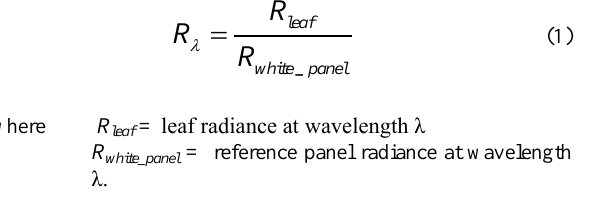
Figure. 1 is the optical diagram of HSL system. The laser emission component of HSL is a wide-band “white” laser with a frequency of 20–40 k Hz and a pulse duration of 1–2 ns. The spot diameter of this laser is about 10 mm and the divergence angle is less than 3 mrad when it is transmitted to the target. A